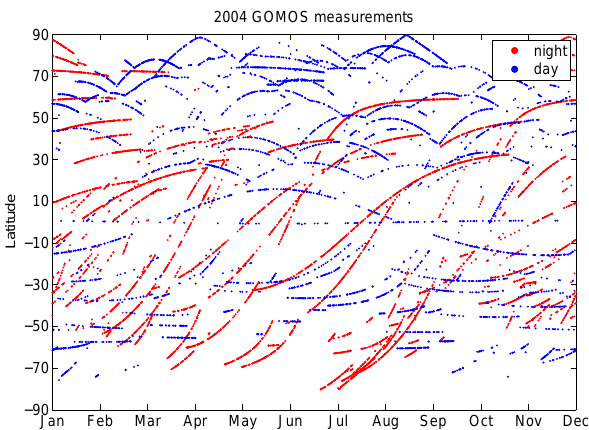
Fig. 11. Distribution of the night and daytime measurements from GOMOS during